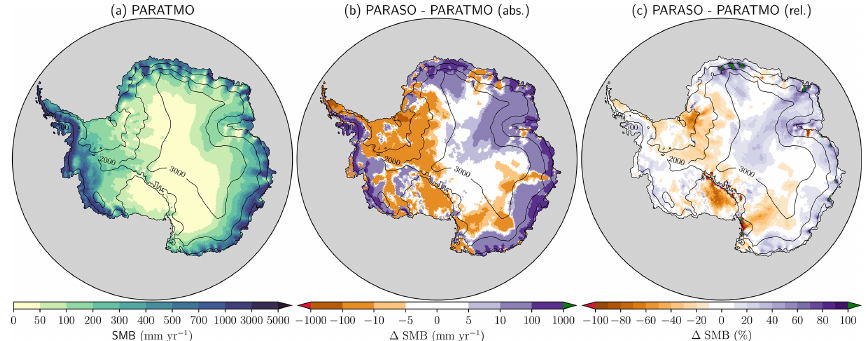
Figure A5. 2001 average of SMB for (a) PARATMO, (b) PARASO–PARATMO absolute difference and (c) PARASO–PARATMO relative difference. Note the nonlinear color scales. Contours denote elevation at 500, 2000 and 3000m above mean sea level.